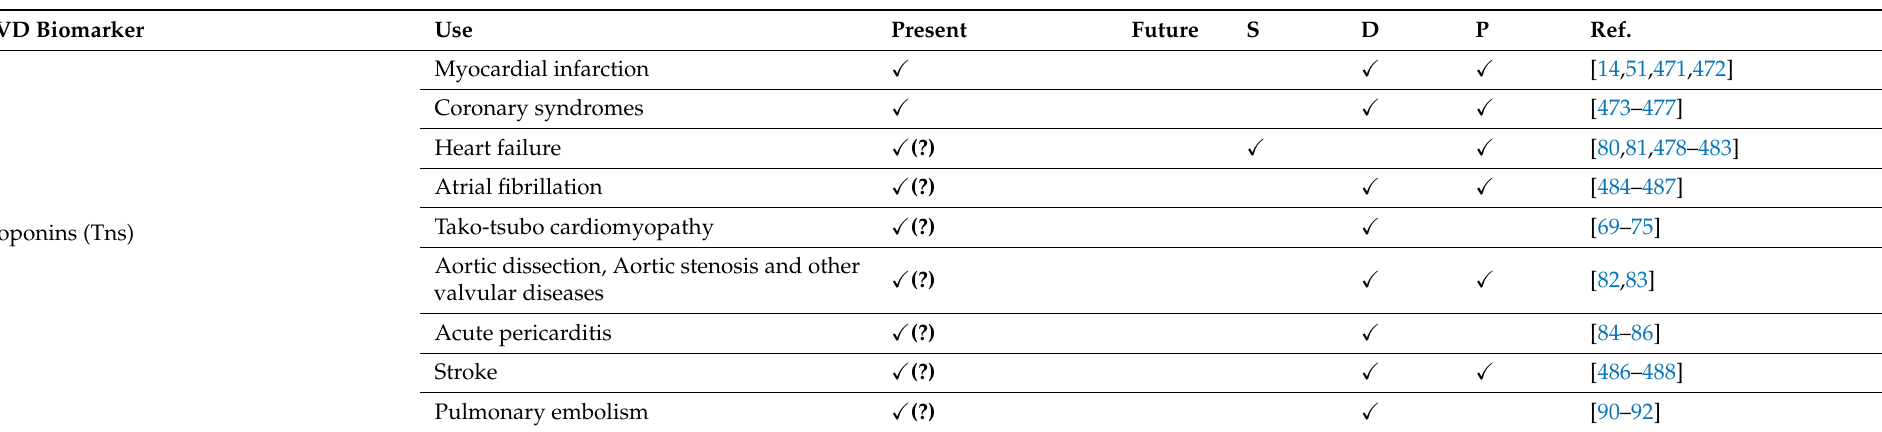
Table 1. Details of selected key established and emerging biomarkers for cardiovascular diseases (CVD). For myocardial infarction (MI), troponins (Tns) are the main biomarker used in current clinical practice for diagnosis, along with natriuretic peptides (NPs) for prognosis. Candidate biomarkers that provide additional information for prognosis in MI include Adrenomedullin (ADM), Heart-Type Fatty Acid-Binding Protein (H-FABP), Copeptin, P-selectin, Soluble Urokinase -type Plasminogen Activator Receptor (suPAR), Plasminogen Activator Inhibitor-1 (PAI-1), Galectin-3 (GAL-3), Matrix metalloproteinases (MMPs) and their tissue inhibitors (TIMPs), suppression of tumorigenicity 2 (ST2), Growth Differentiation Factor 15 (GDF-15), and Endothelin-1 (ET-1). Indeed, diagnosis and prognosis of coronary syndromes are currently guided by Tns, NPs, whilst P-selectin, suPAR, PAI-1, and GAL-3 could be additionally useful in the context of acute coronary syndromes in the future. Moreover, NPs levels are also used for diagnosis and prognosis of heart failure (HF), whilst Tns, FABP, Copeptin, ADM, MMPs, TIMPs, ST2, GDF-15, ET-1, and GAL-3 could also be helpful as biomarkers for HF screening and prognosis. Similarly, for diagnosis and prognosis of arrhythmias, specifically atrial fibrillation, a number of biomarkers, including Tns, NPs, H-FABP, GDF-15, and pro-inflammatory cytokines are described below. Regarding pro-inflammatory cytokines, interleukin-6 (IL-6), interleukin-8 (IL-8), tumor necrosis factor- α , and intercellular adhesion molecule-1 impact arrhythmogenic activity and could